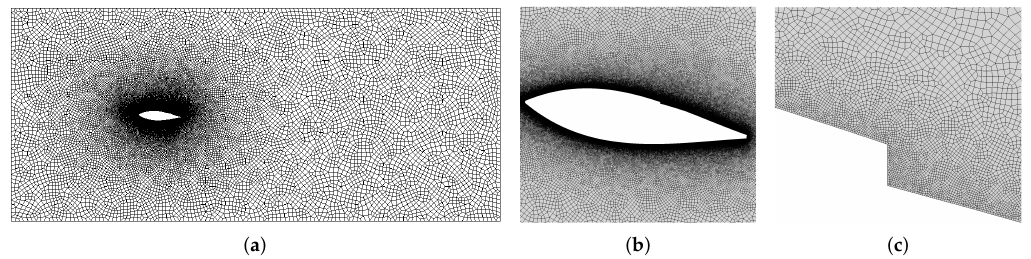
Figure 1. Schematic of computational domain.